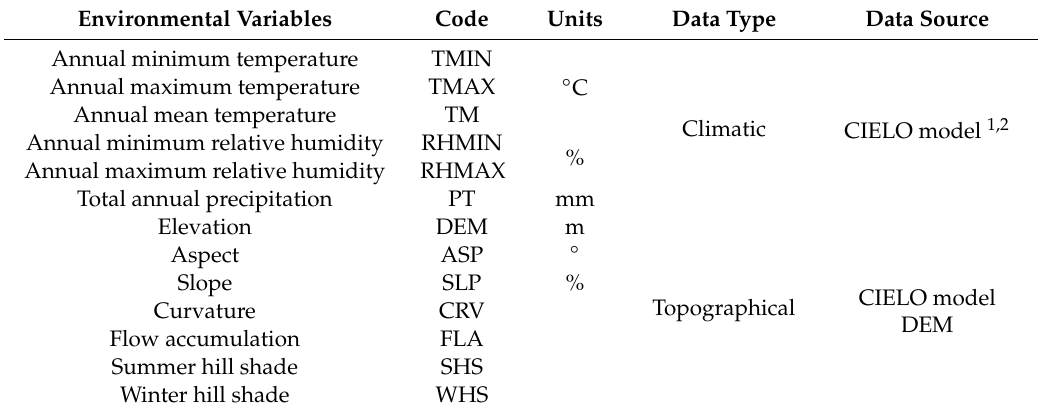
Table 1. General characterization of the ecogeographical variables used in the species distribution